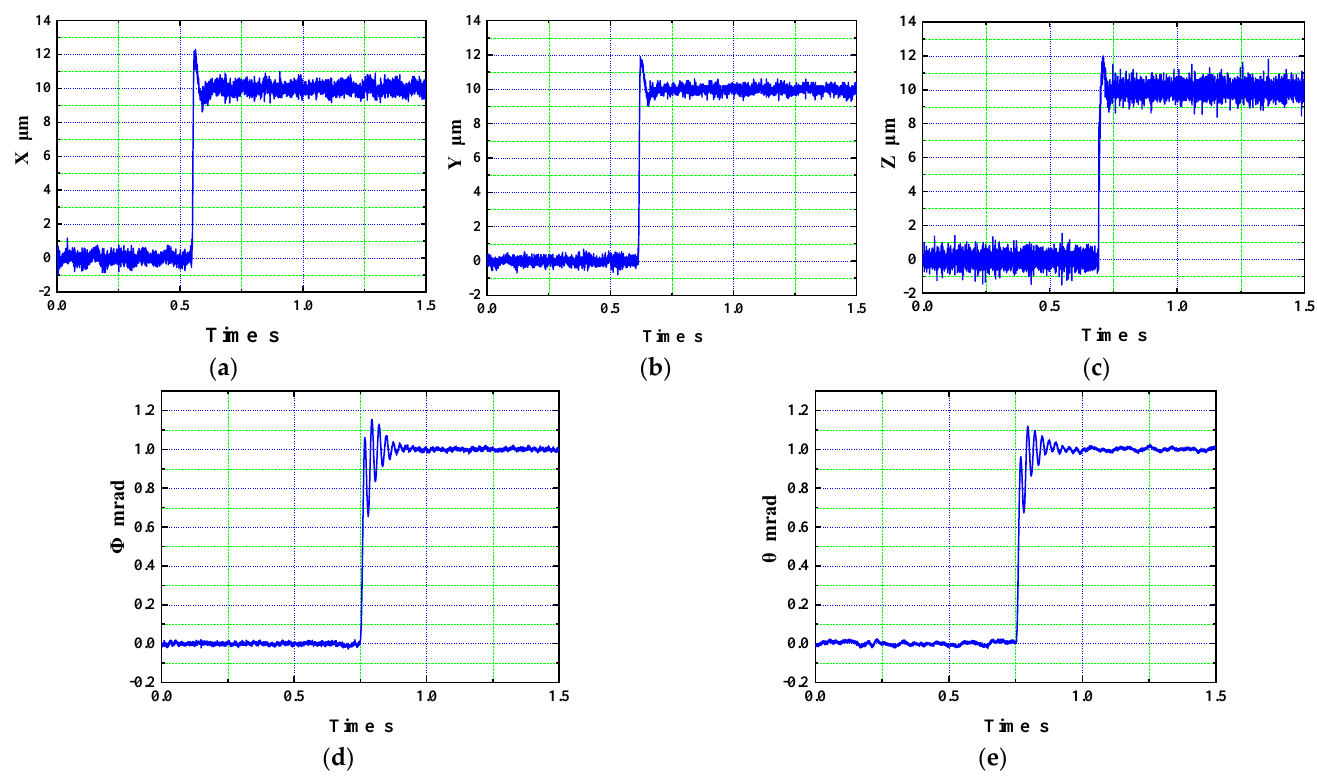
Figure 13. Structure of the experimental system. ( a ) Step response in the X direction; ( b ) Step response in the Y direction; ( c ) Step response in the Z direction; ( d ) Step response in the Φ direction; ( e ) Step response in the θ direction.